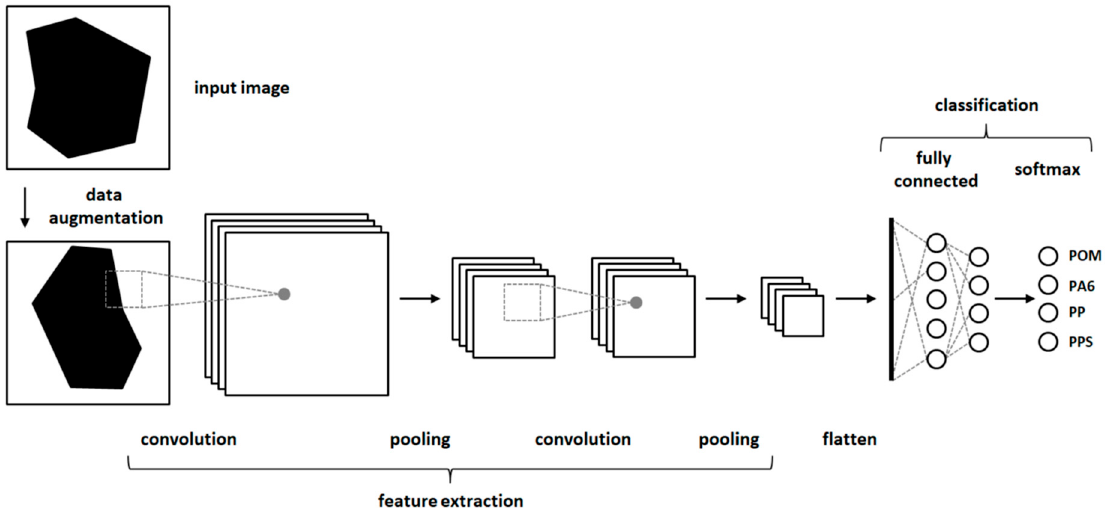
Figure 3. A schematic structure of a convolutional neural network (CNN).